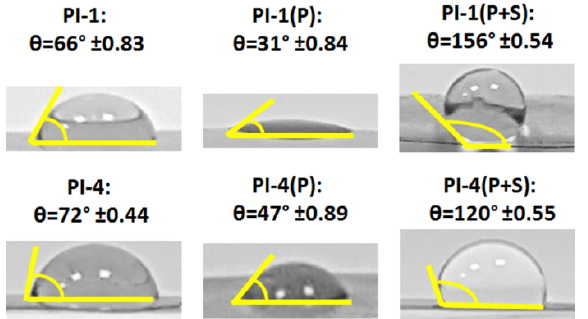
Figure 10. The variations of the contact angle of the pristine PI-1 and PI-4 films, after plasma modification of PI-1(P) and PI-4(P), and after plasma exposure succeeded by spraying PI-1(P+S) and PI-4(P+S).